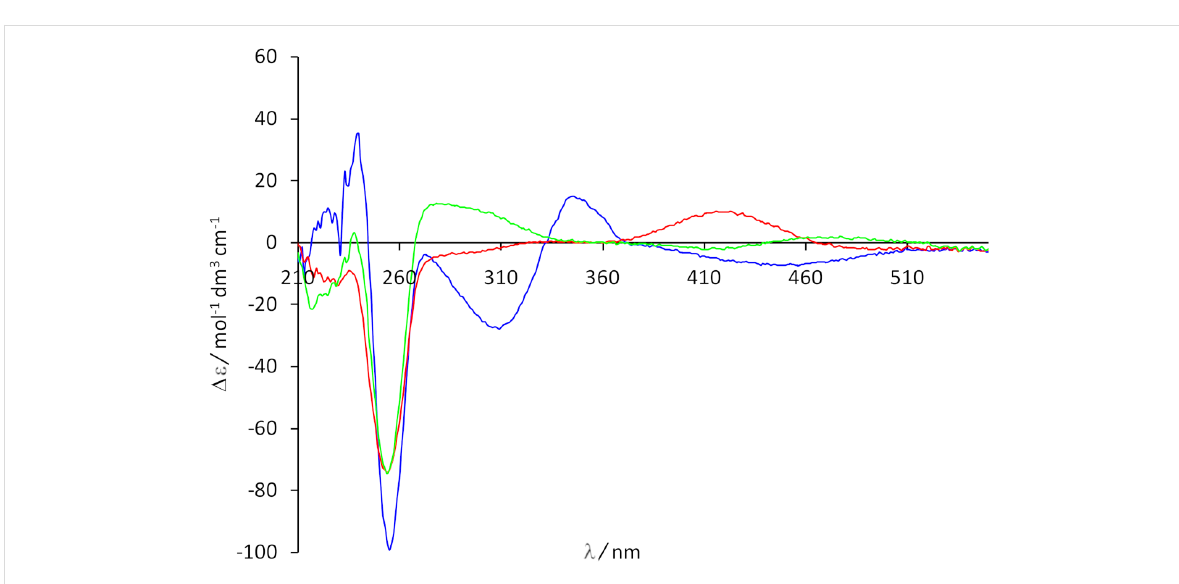
Figure 7: CD spectra of trans , trans - 10 (blue), cis , trans - 10 (green), and cis , cis - 10 (red) in methanol ( c = 3.0 × 10 − 5